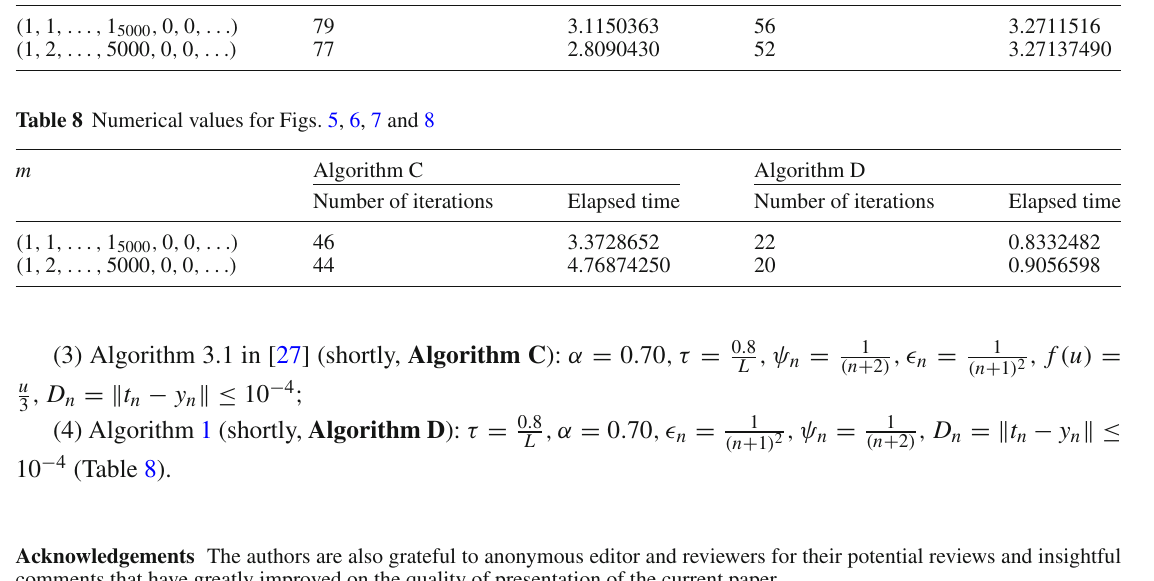
Table 7 Numerical values for Figs. 5, 6, 7 and 8 m Algorithm A Algorithm B Number of iterations Elapsed time Number of iterations Elapsed time ( 1 , 1 ,..., 1 , 0 , 0 ,...) 5000